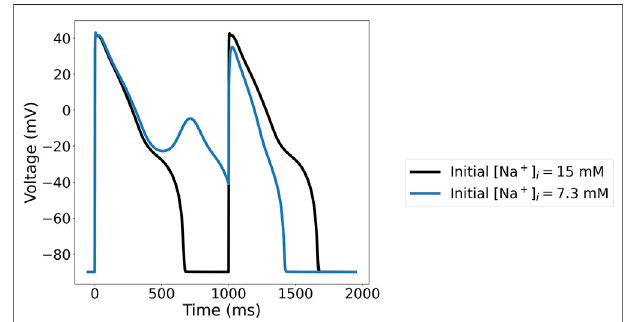
FIGURE 9 | Limit cycle APs for the ORd-CiPA model under 95% of I Kr reduction, generated with the same value for Γ 0 = − 20 mM, but different initial Na + concentrations. With the initial Na + concentration set to 15 mM (Black), the limitcycleAPshows noearlyafter-depolarisation (EAD).With alower initial Na + concentration of 7.3 mM (Blue), the limit cycle AP exhibits alternans with an EAD.